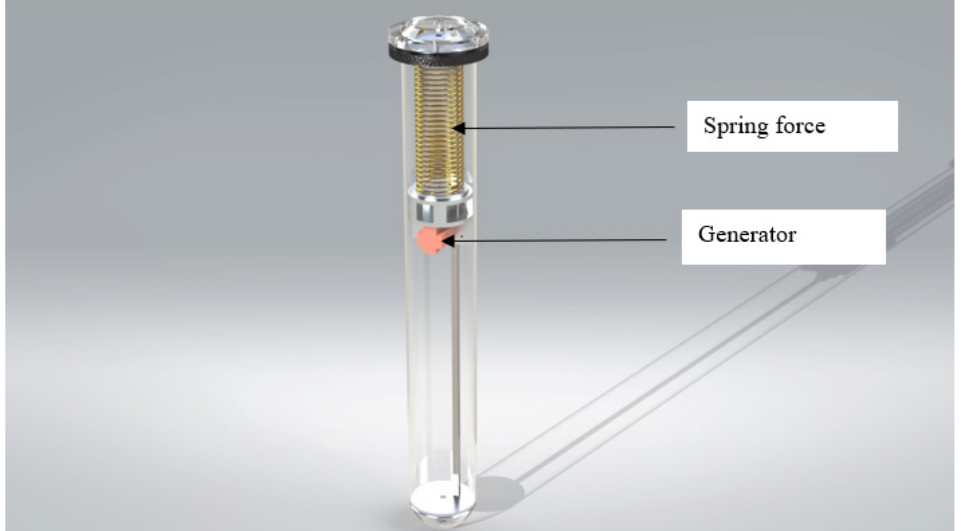
Figure 1. Schematic of a point-absorber WEC with direct mechanical PTO (designed by the authors). The wave F e exerted on a heaving point absorber is made up of both wave diffraction and Froude–Krylov forces. This force emanates from the incident wave striking the WEC’s surface, which is held still in the water, arising from the potential flow wave theory. In order to calculate the wave F e , it is required to integrate both the diffracted wave potential and the incident wave pressure (i.e., Froude–Krylov) over the surface of the WEC, as indicated in Equation (16)